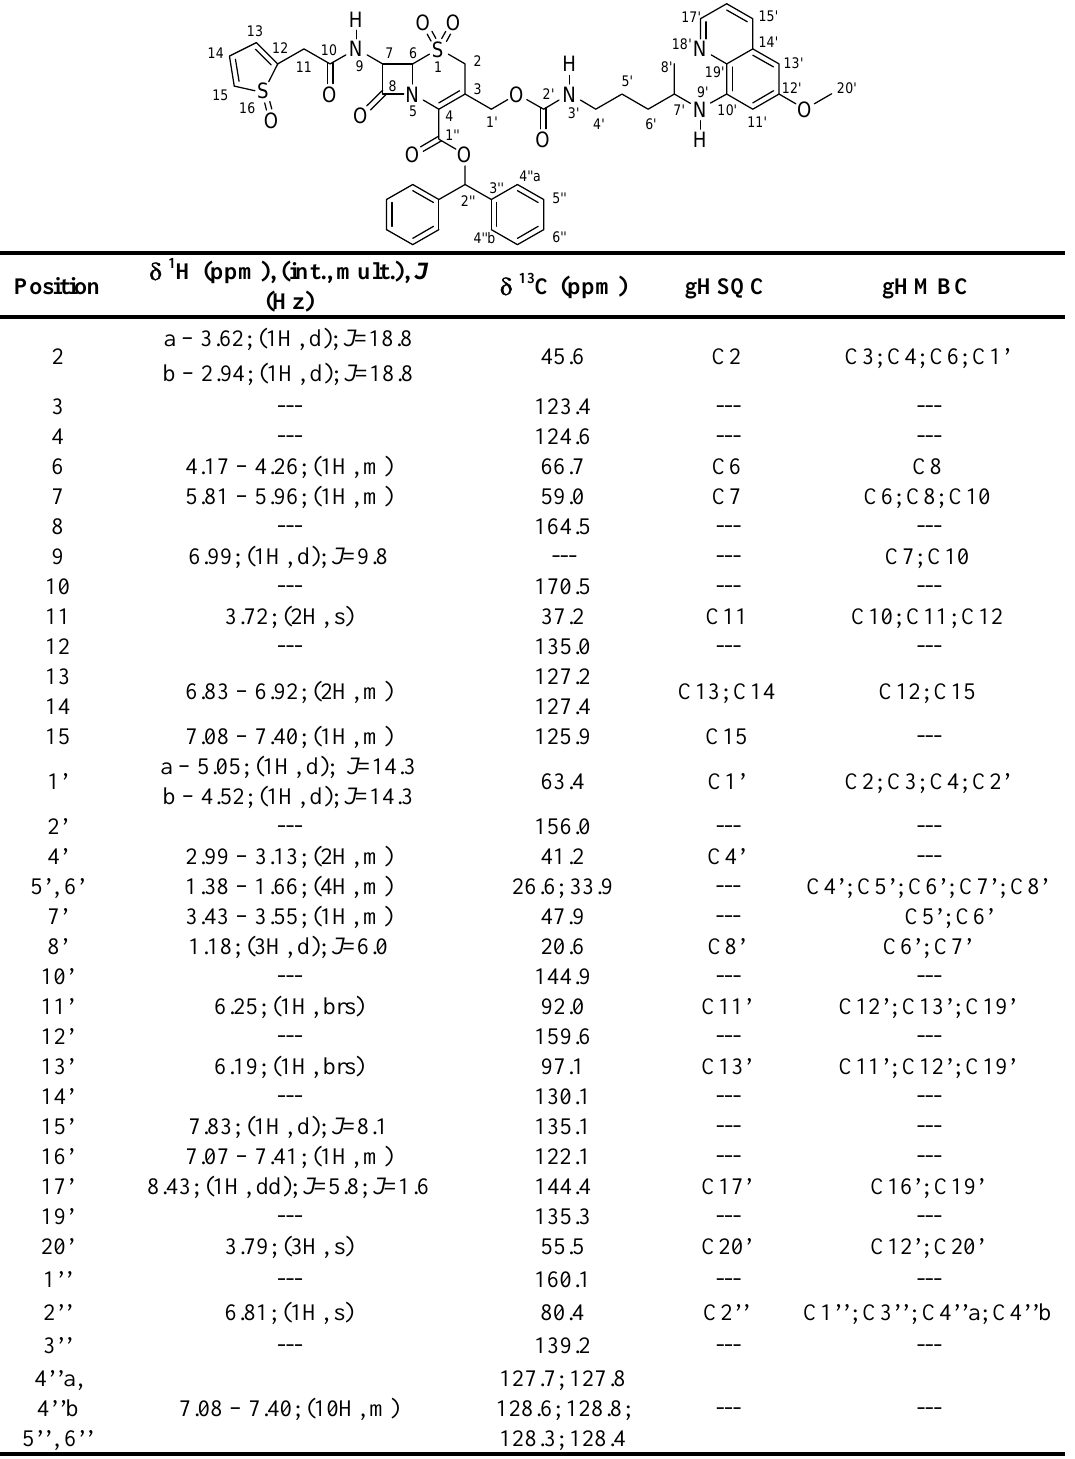
Table 2. 1 H- and 13 C-NMR chemical shifts for compound 6